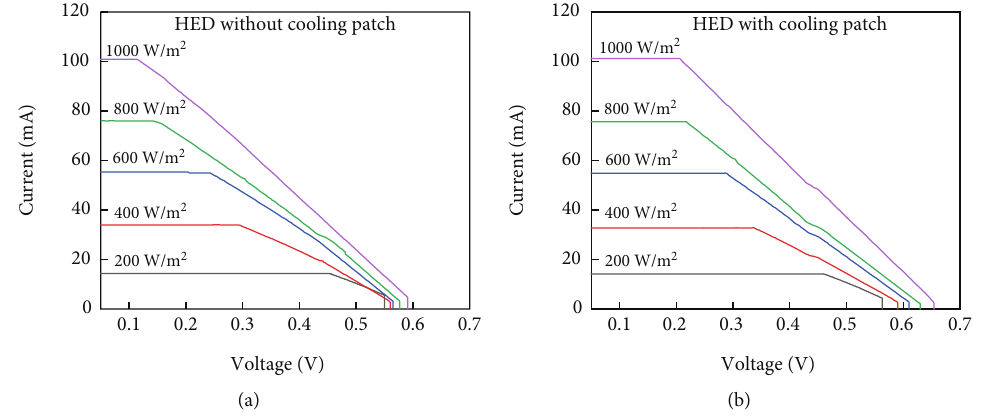
Figure 4: The I - V curves of the HEDs (a) without cooling patch and (b) with cooling patch.